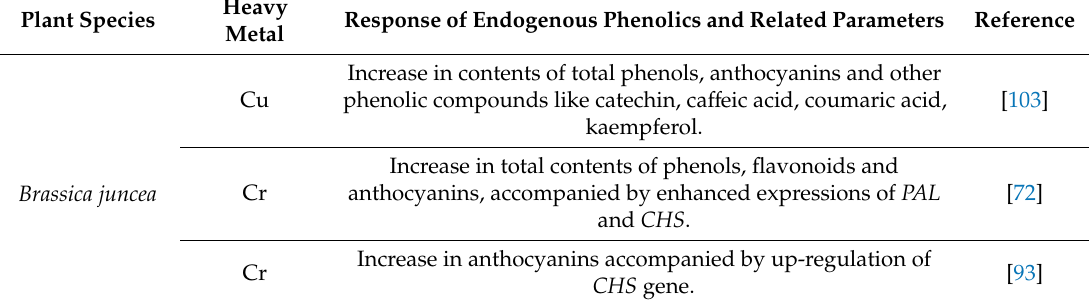
Table 1. Summary table describing the impact of heavy metal stress on the endogenous levels of various phenolic compounds in